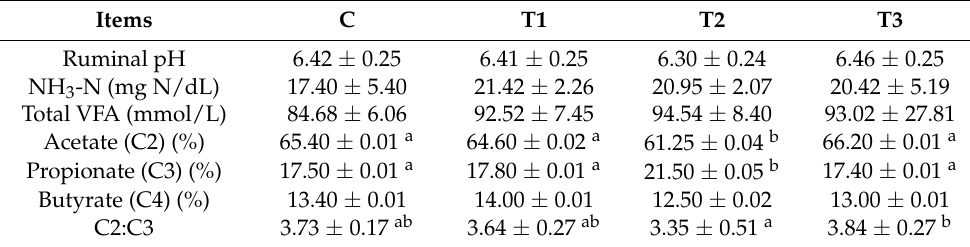
Table 3. Effects of dietary BM1259 on ruminal fermentation in lactating dairy cows.